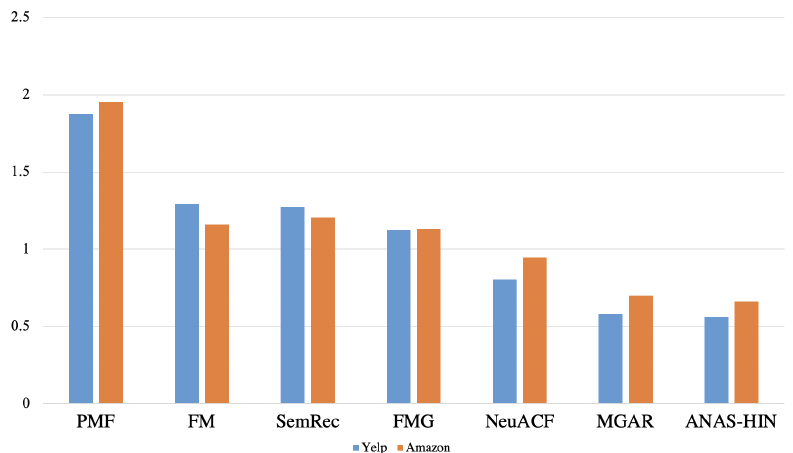
Figure 5. Experimental results on Yelp and Amazon datasets.